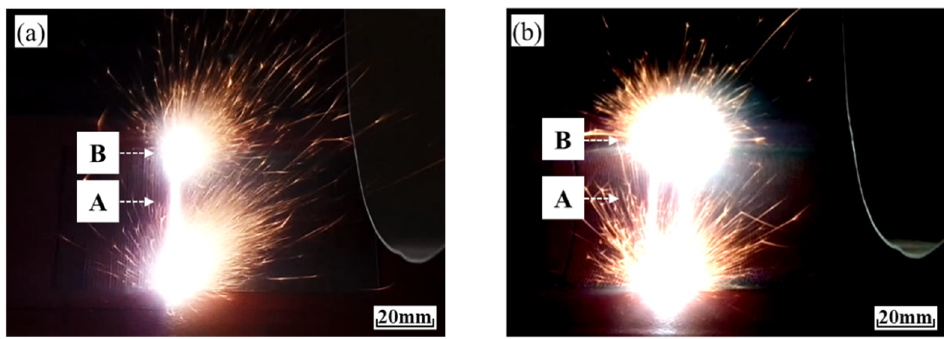
Figure 5. Laser-cleaned surfaces of epoxy-painted steel with the laser beam scanning patterns.